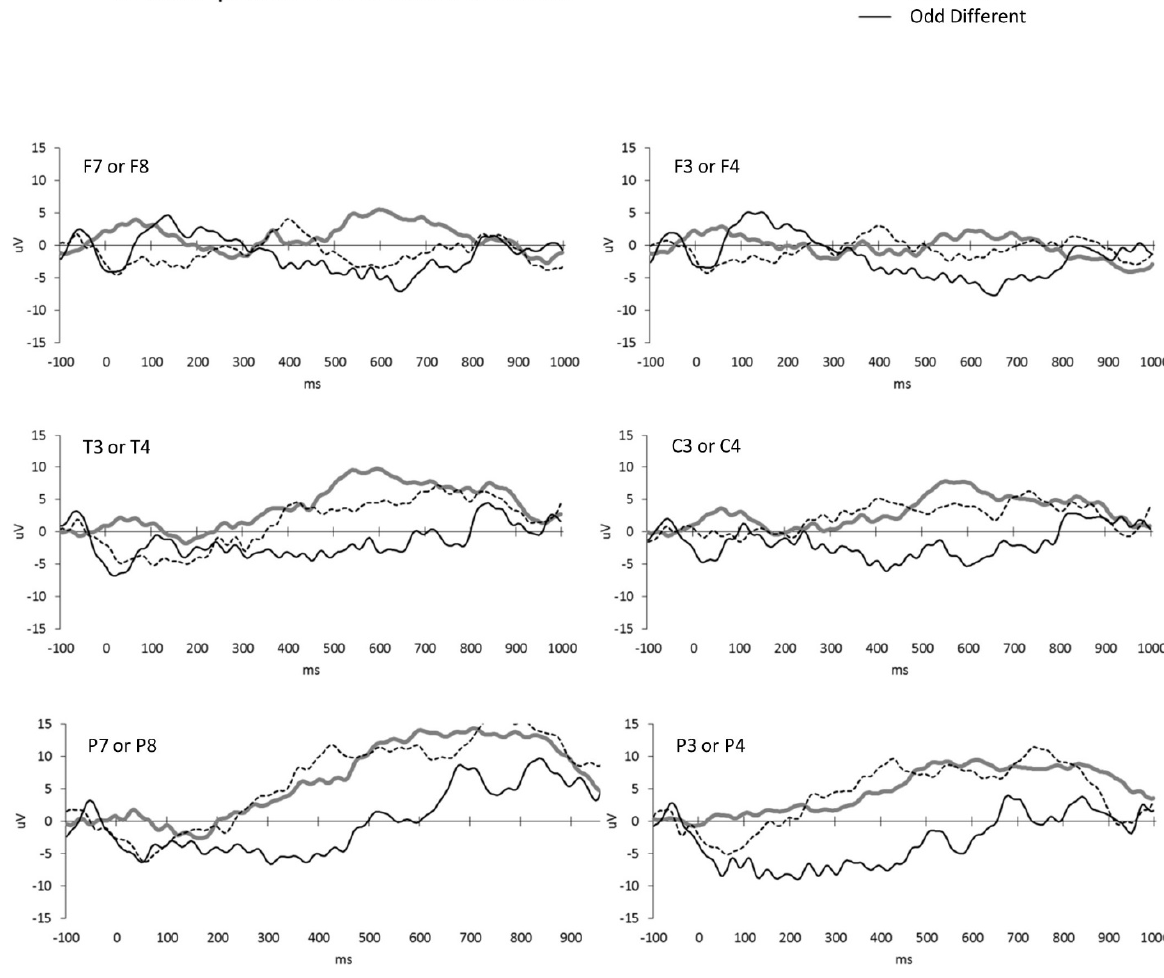
Figure 2. Average waveforms by condition, scalp recording site (e.g., F7 or F8), and stimulus presentation hemi fi elds: ( A ) contralateral and ( B ) ipsilateral.